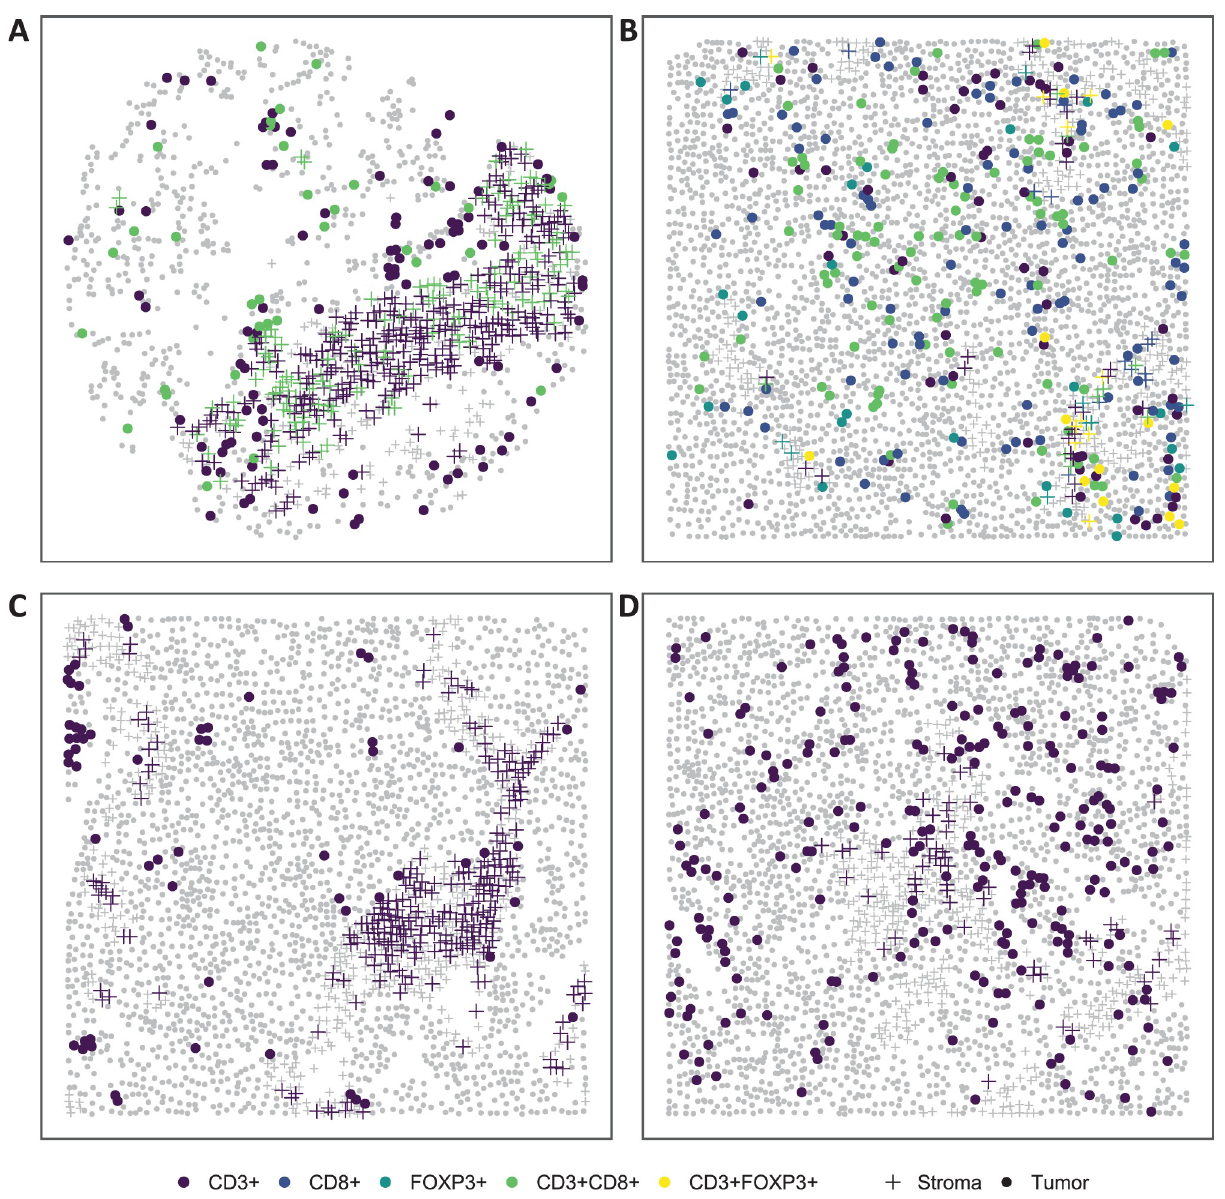
Fig 1. Example of IF data from (A) a TMA core sample and (B) an intra-tumoral region of interest (ROI). As illustrated in the two example figures, TMAs tend to have more “holes” and uneven cell density as compared to ROIs. Examples of clustering patterns observed in the intra-tumoral ROIs; (C) locations of CD3+ cells in which the pattern deviates from complete spatial randomness (CSR); and (D) location of CD3+ cells in which the pattern is close to